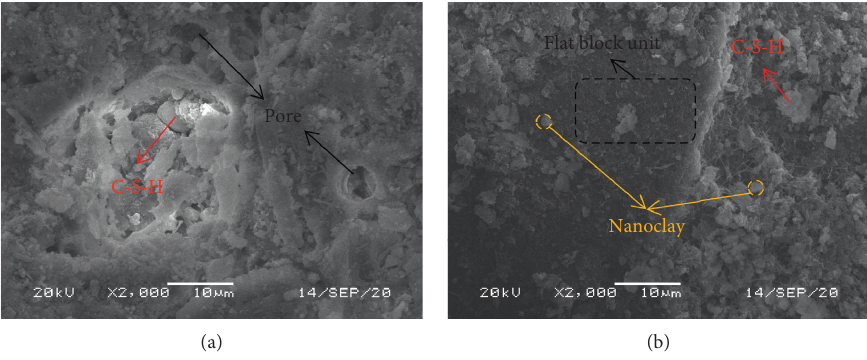
Figure 14: Microstructure of (a) CCS and (b) NCCS.